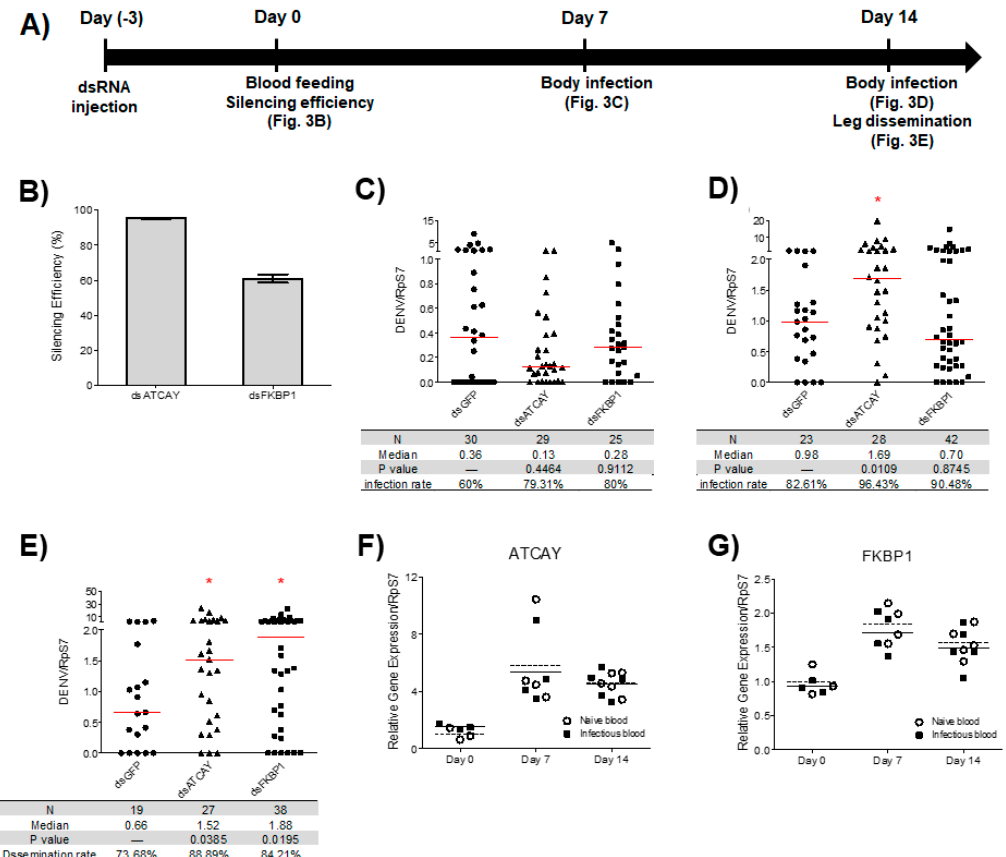
Figure 3. dsRNA-mediated silencing assay during DENV2 infection in adult mosquitoes. Mosquitoes were injected with dsRNA against AeATCAY (AAEL021611) or AeFKBP1 (AAEL007883) and infected with DENV2 through infectious blood feeding. ( A ) Experimental design. ( B ) Silencing efficiencies were determined by quantitative real-time PCR compared to the control (dsGFP injected) and presented as means (60.92% for AeFKBP1 and 95.47% for Ae ATCAY) and standard errors (n = 3). ( C ) Relative viral RNA was measured in whole bodies at 7 days post-infection (dpi) and compared to the control. ( D , E ) Relative viral RNA was measured in whole bodies without legs ( D ) and in legs ( E ) at 14 dpi. ( C – E ) DENV2 RNA copy number was normalized to RpS7 (AAEL009496) and compared to the control (dsGFP injected). The red bar indicates a relative and normalized median DENV2 copy number. Statistical analyses were performed by the Mann-Whitney U test. Gene expression of ( F ) AeATCAY (AAEL021611) and ( G ) AeFKBP1 (AAEL007883) in infected mosquitoes were compared to naïve blood-fed mosquitoes at 0, 7 and 14 days post-infection. Transcript levels of both genes were not affected by DENV2 infection in mosquitoes at 7 and 14 days post-blood feeding ( F , G ) Statistical analyses were performed by two way ANOVA; ( F (1, 18) = 0.0001322, p = 0.9910) for AeATCAY; ( F (1, 18) = 0.7567, p = 0.3958) for AeFKBP1.